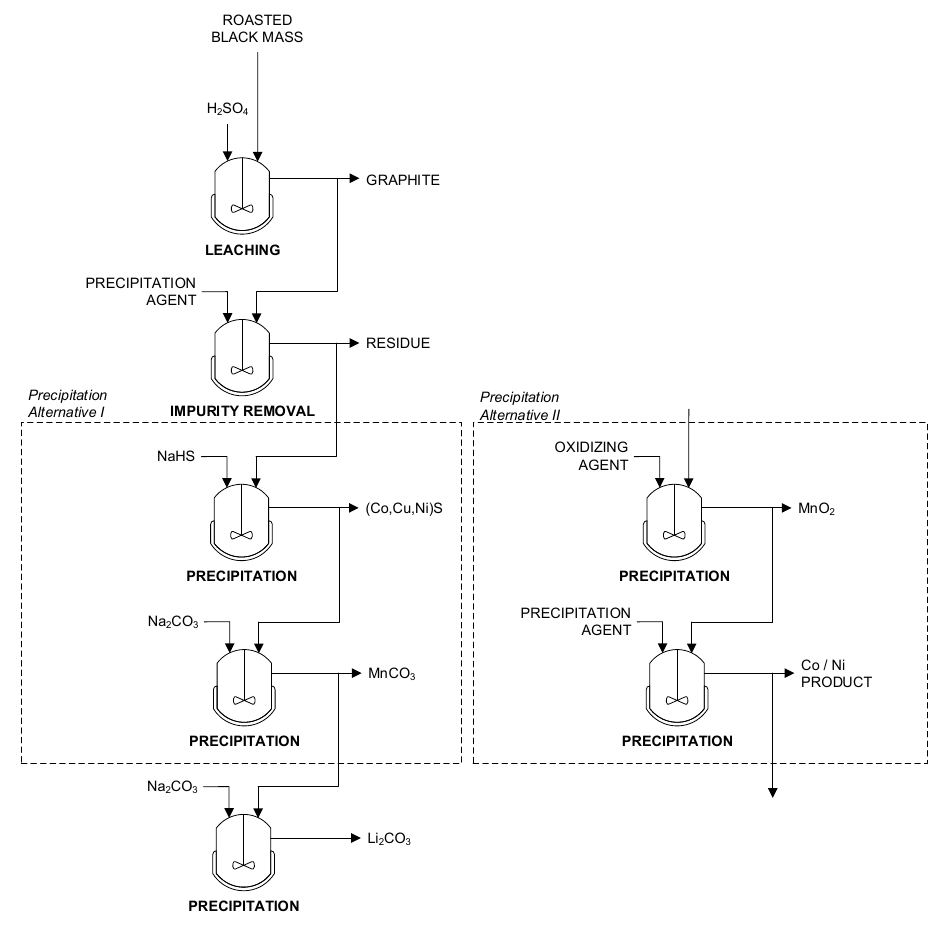
Figure 9. Simplified flowsheet for the hydrometallurgical route for the production of intermediates based on [12,80].